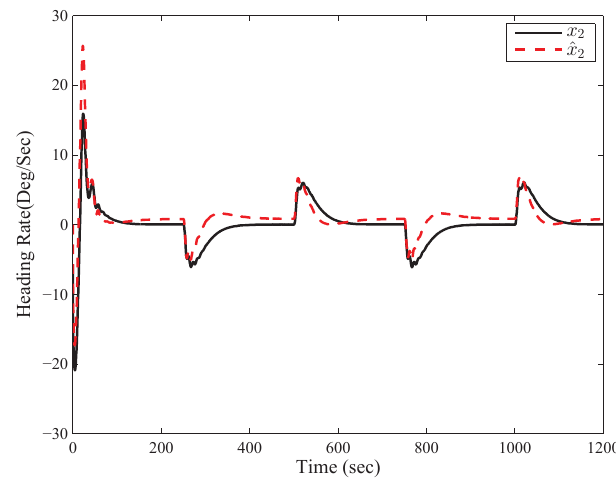
Figure 7. Curves of ship’s heading rate and its estimation.